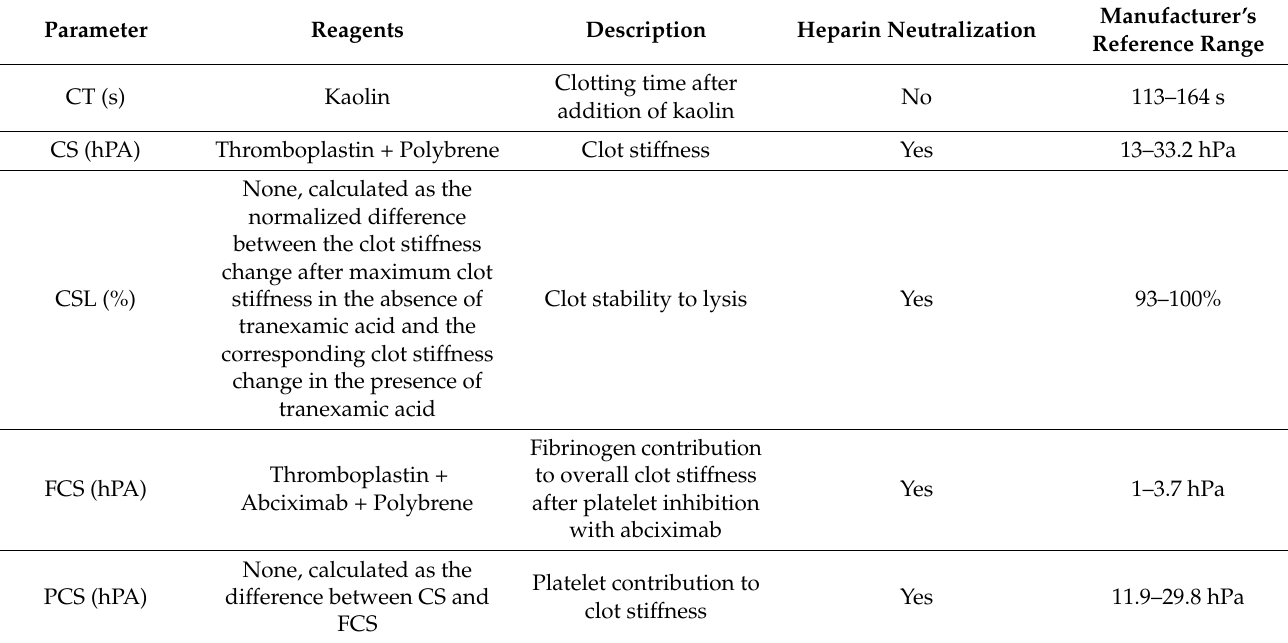
Table A6. Quantra®QStat cartridge and